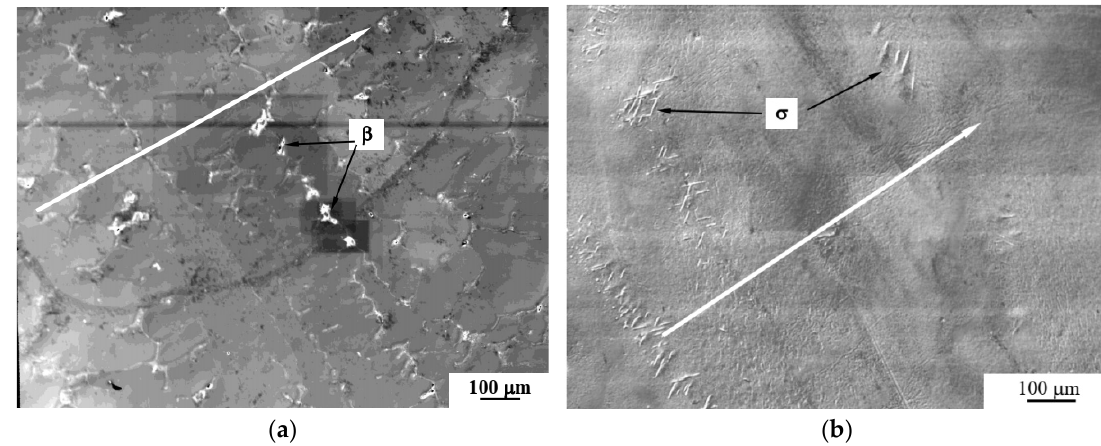
Figure 5. Scanning electron microscopy (SEM) images of the alloy structure: ( a ) image of the alloy after DC; ( b ) image of the alloy after DC and annealing. The black arrows in ( a ) mark examples of particles of the β -phase, and those in ( b ) mark the σ -phase; white arrows show the direction of pe-riodicity.